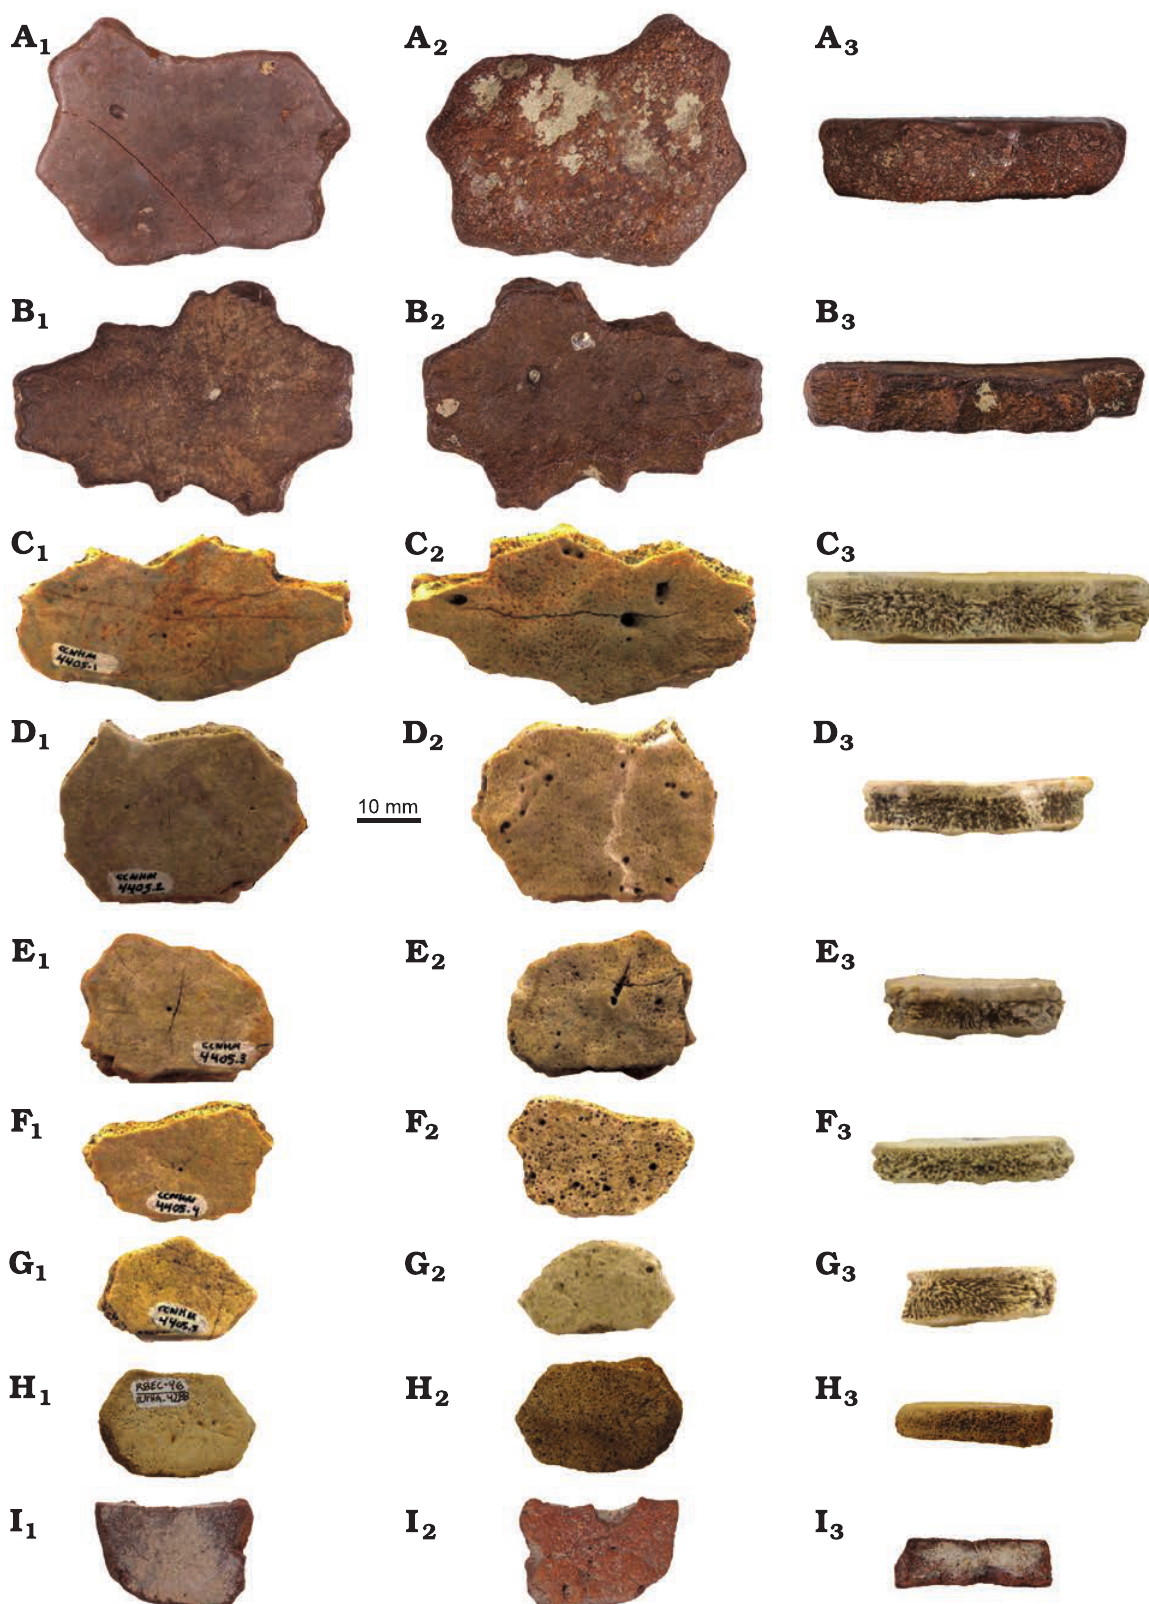
Fig. 2. Ossicles of leatherback turtle Natemys sp. 1 from Oligocene of South Carolina, USA. CCNHM 5542 ( A ), CCNHM 5540 ( B ), CCNHM 4405.1– 4405.5 ( C – G , respectively), CCNHM 4288 ( H ), and CCNHM 5541 ( I ), in dorsal (A 1 –I 1 ), visceral (A 2 –I 2 ), and sutural (A 3 –I 3 )